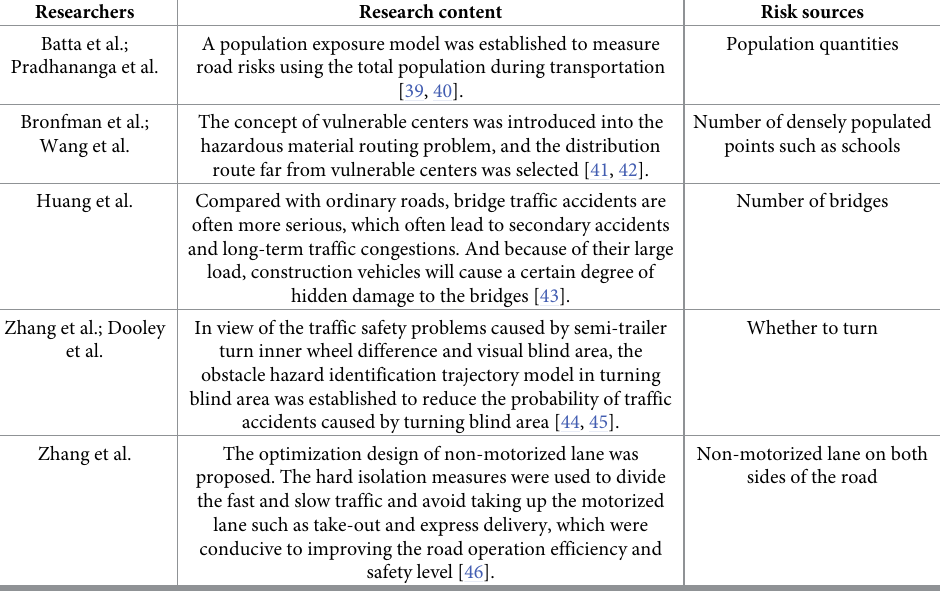
Table 1. Summary of urban road risk